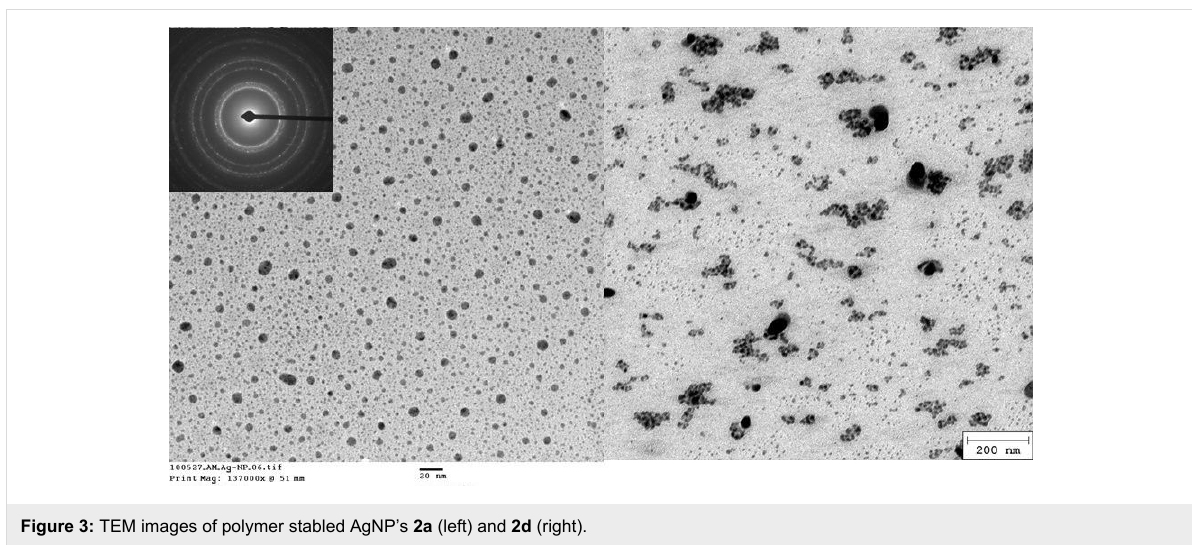
Figure 3: TEM images of polymer stabled AgNP’s 2a (left) and 2d (right).